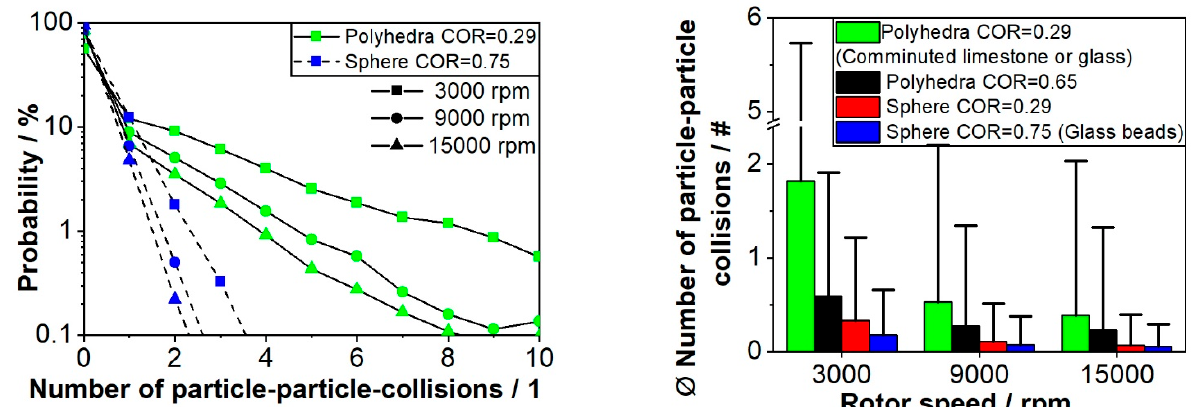
Figure 11. Simulation results regarding the particle–particle-collisions in the deflector wheel classifier for spherical and non-spherical particles at different rotor speeds. ( Left ) shows the probability distribution of the number of contacts for polyhedral particles with a low coefficient of restitution (comminuted limestone or glass) and spheres with a high coefficient of restitution (glass beads). This is the probability that a particle has 0, 1, . . . particle–particle-collisions in the paddle interspace; ( Right ) Mean number of particle–particle interactions plus one standard deviation occurring on the path from inlet to outlet surface.